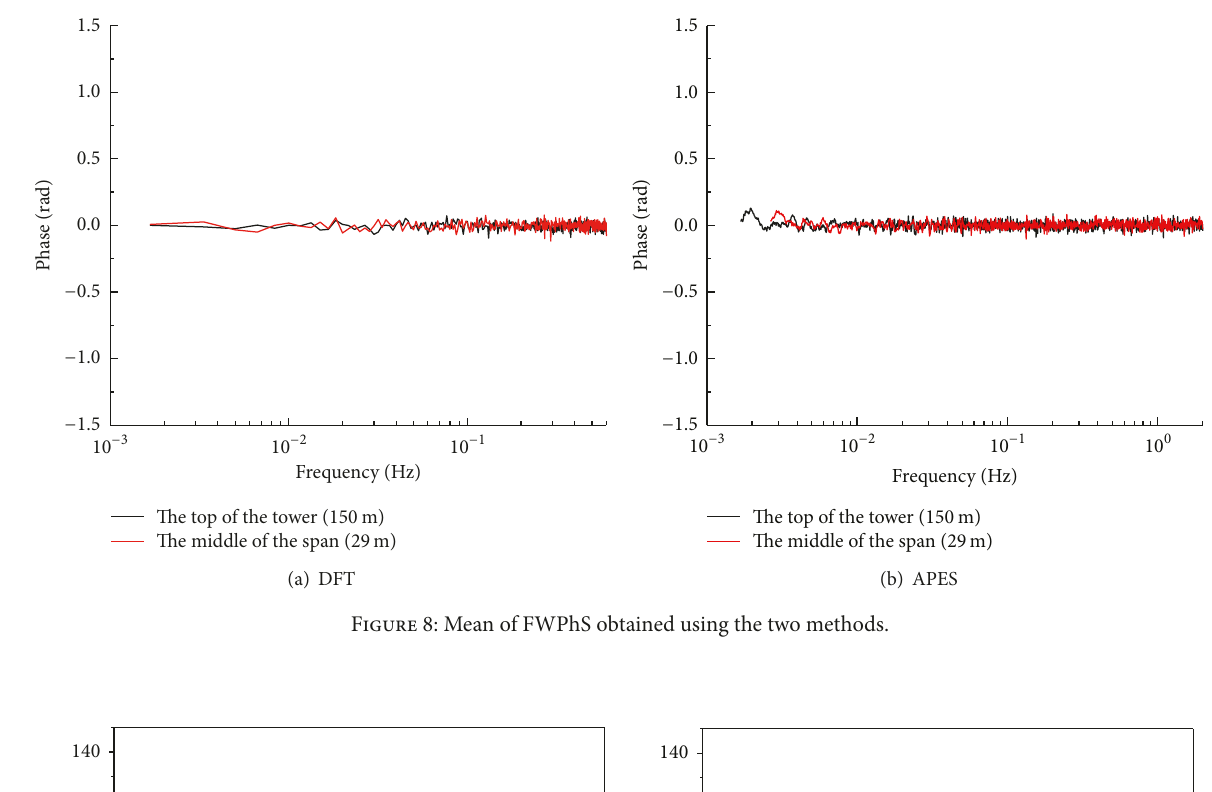
Figure 8: Mean of FWPhS obtained using the two methods.